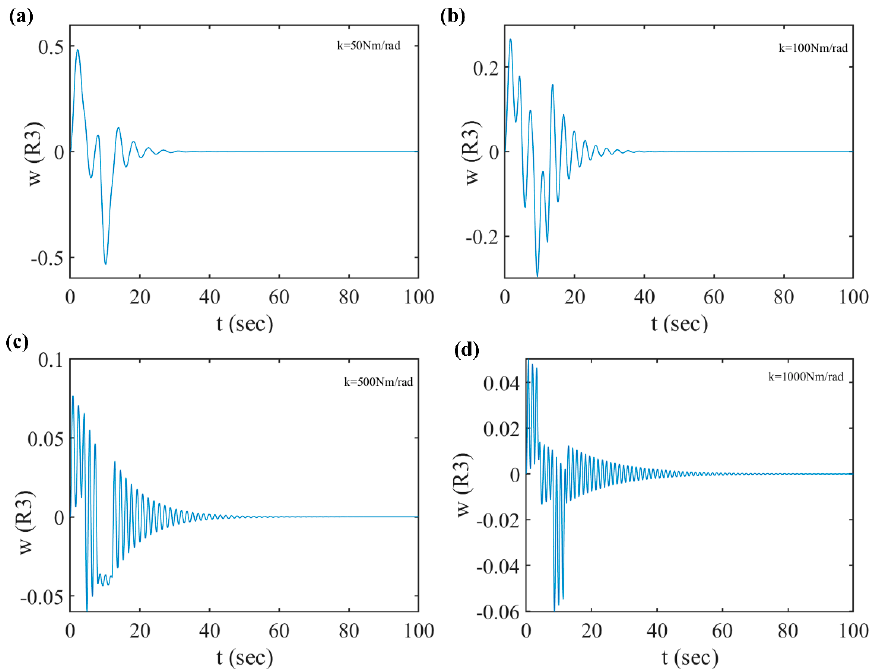
Figure 9. Deflections of the solar array tip for different spring stiffnesses; they are listed as: ( a ) k = 50 N · m/rad; ( b ) k = 100 N · m/rad; ( c ) k = 500 N · m/rad; ( d ) k = 1000 N ·